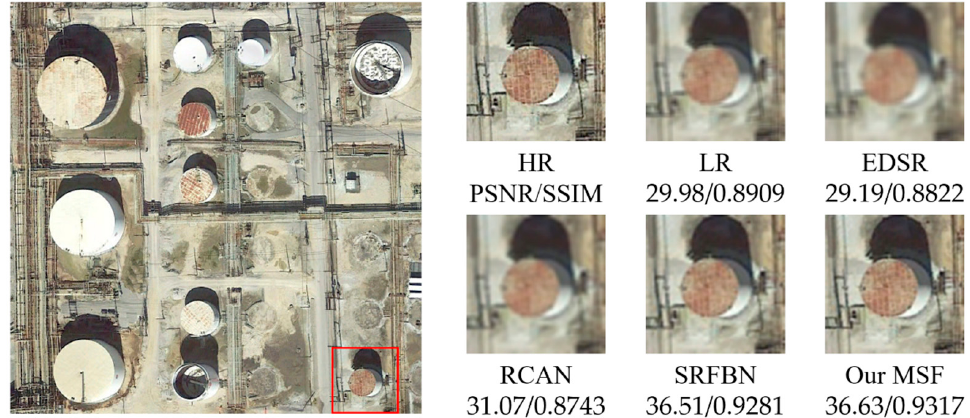
Figure 9. Qualitative comparison between different SR models performance on storage tank instance-class.